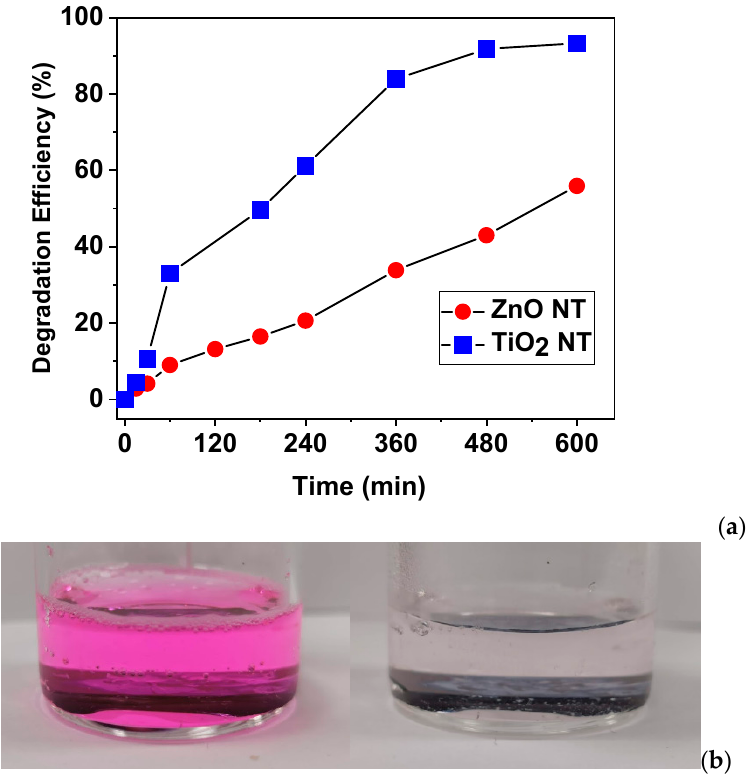
Figure 7. ( a ) Degradation efficiency of ZnO and TiO 2 nanotubes; ( b ) RhB solution before and after irradiation under solar simulator light.